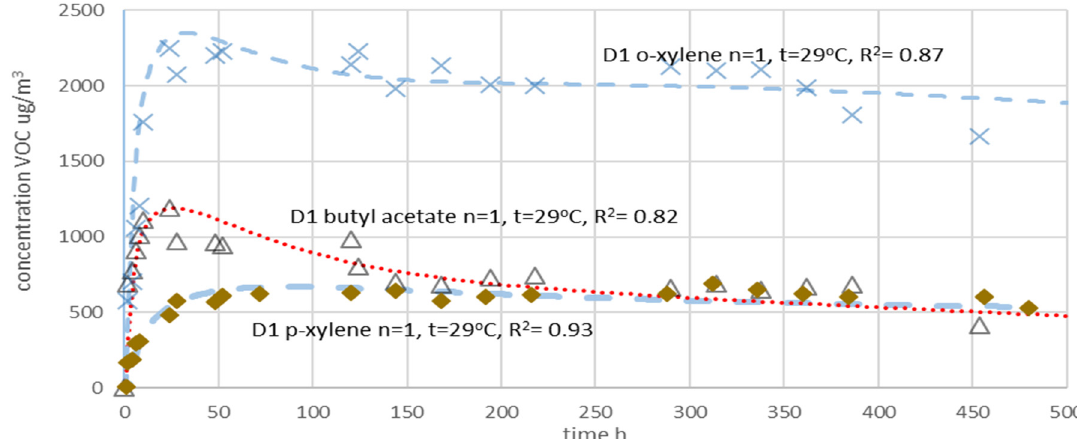
Figure 16. The selected VOCs emission profiles from D1 floor systems (tested for 480 h) for the air change rates n = 1 h − 1 at 29 °C (and RH = 50% for both) in the emission test chamber, including butyl acetate, o-xylene and m-p-xylene (D1 sample is a floor system made of: polyurethane solvent primer and polyurethane adhesive).